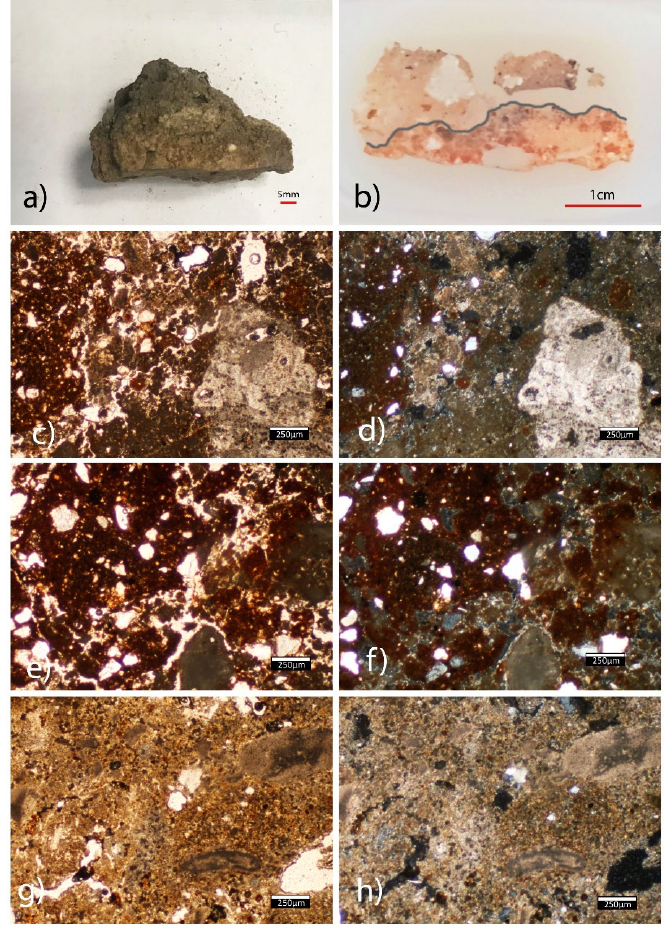
Figure 8. Sample MIN1 (Group P2b) microphotographs under polarised light microscopy (PL ‐ OM). Mortar with cocciopesto and silicatic aggregate with a layer of slightly compacted clay and combustion traces. ( a ) analysed fragment; ( b ) thin section with stratification in two layers: cocciopesto mortar (lower layer) and mortar with a few pluri ‐ millimetric fragments of limestone (upper layer); ( c ) parallel polars and ( d ) crossed polars: cocciopesto, quartz, feldspars, and a lime ‐ stone fragments in mortar aggregate; ( e ) parallel polars and ( f ) crossed polars: cocciopesto, quartz and a lime ‐ lump; ( g ) parallel polars and ( h ) crossed polars: microcrystalline calcitic binder.